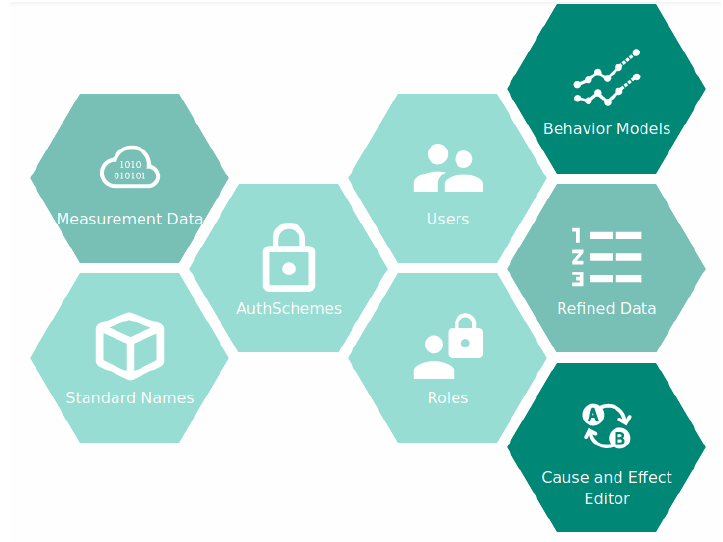
Figure 3. Generic applications of the Engineering Data Intelligence (EDI) hive Internet of Things (IoT) framework.